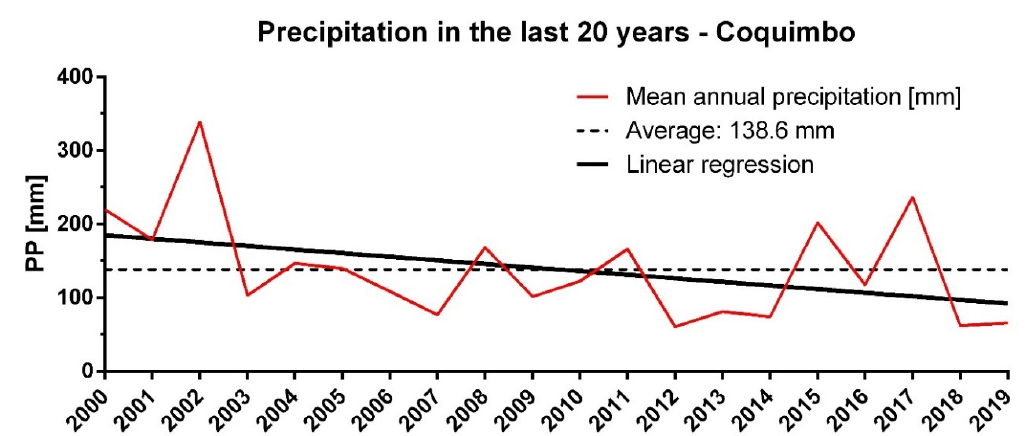
Figure A1. Average precipitation in Coquimbo Region in the last 20 years using the Thiessen polygon method. The mean annual precipitation in the range of years studied and the linear regression are also presented. Source: Prepared by the authors based on meteorological data from the Climate Explorer that uses compiled databases of the weather observations available for Chile [22].